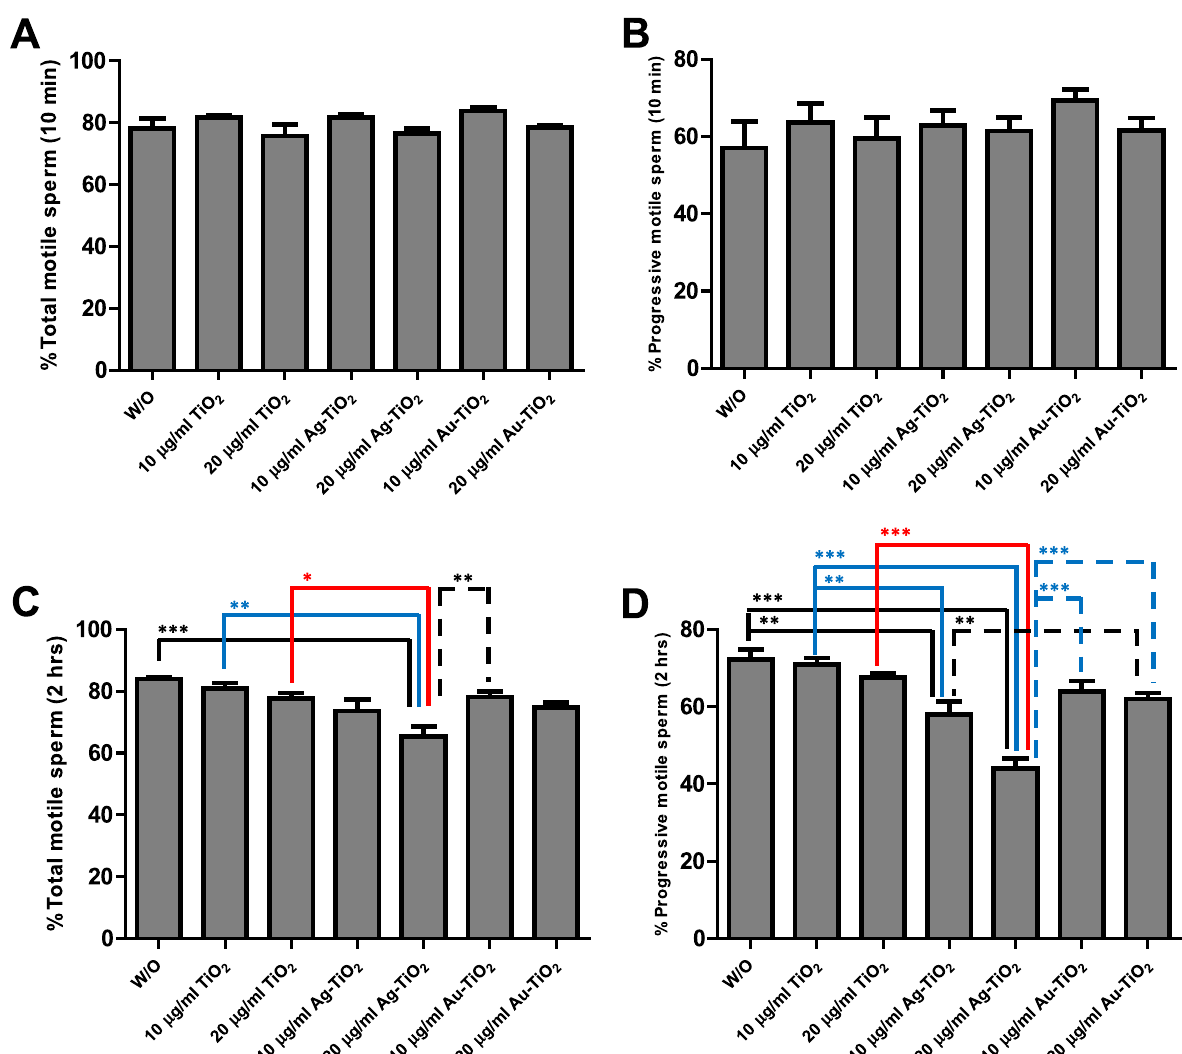
Fig. 3 Comparison of total motile sperm and progressive motile sperm after incubation with or without (W/O) TiO 2 NRs. Boar spermatozoa were incubated in the presence of TiO 2 NRs for 10 min ( A , B ) and 2 h ( C , D ). Values are expressed as mean denote significant differences at * p < 0.05, ** p < 0.01 and *** p <